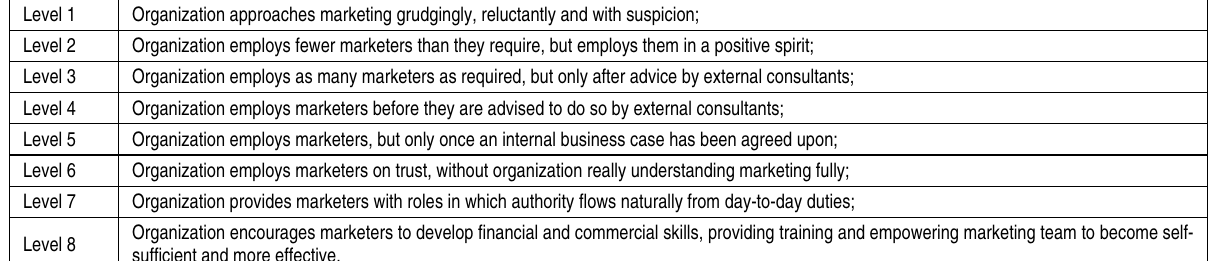
Table 2. Commitment to marketing within a